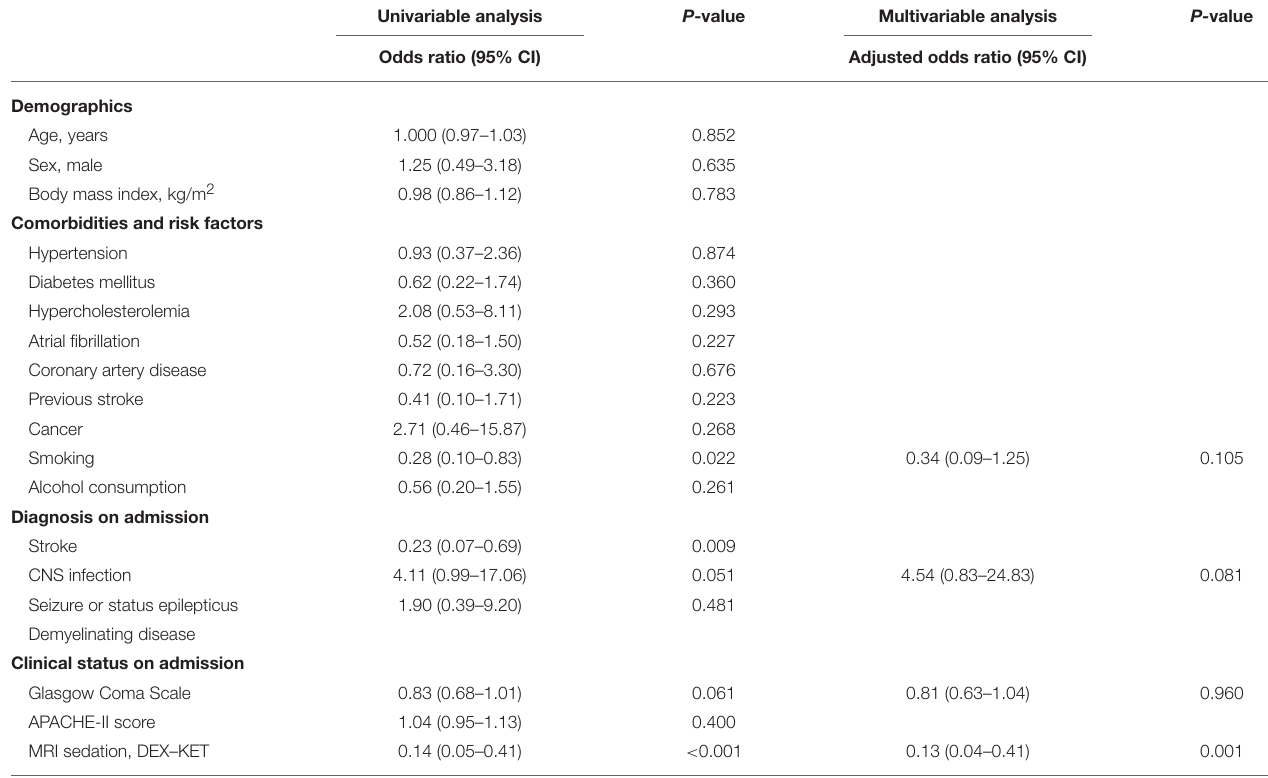
TABLE 4 | Factors associated with sedation-related